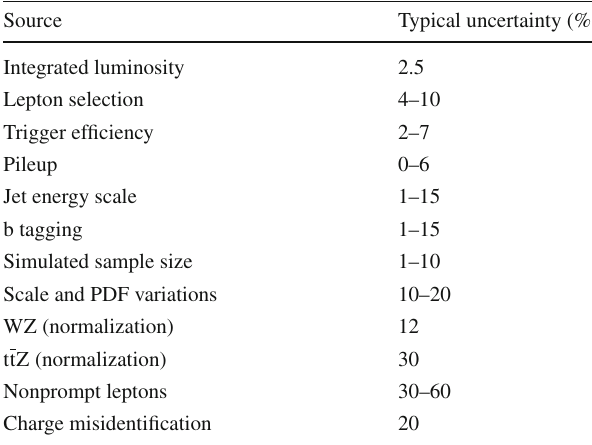
Table 5 Summary of the sources of uncertainty and their effect on the yields of different processes in the SRs. The first eight uncertainties are related to experimental and theoretical factors for processes estimated using simulation, while the last four uncertainties are assigned to pro- cesses whose yield is estimated from data. The first seven uncertainties also apply to signal samples. Reported values are representative for